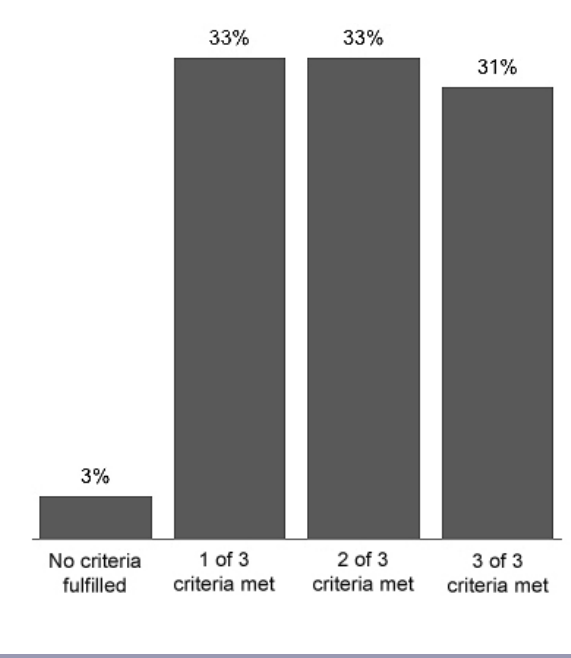
Fig. 5. Respondents’ perceptions of how many of the three criteria for conceptual model development are met in their current